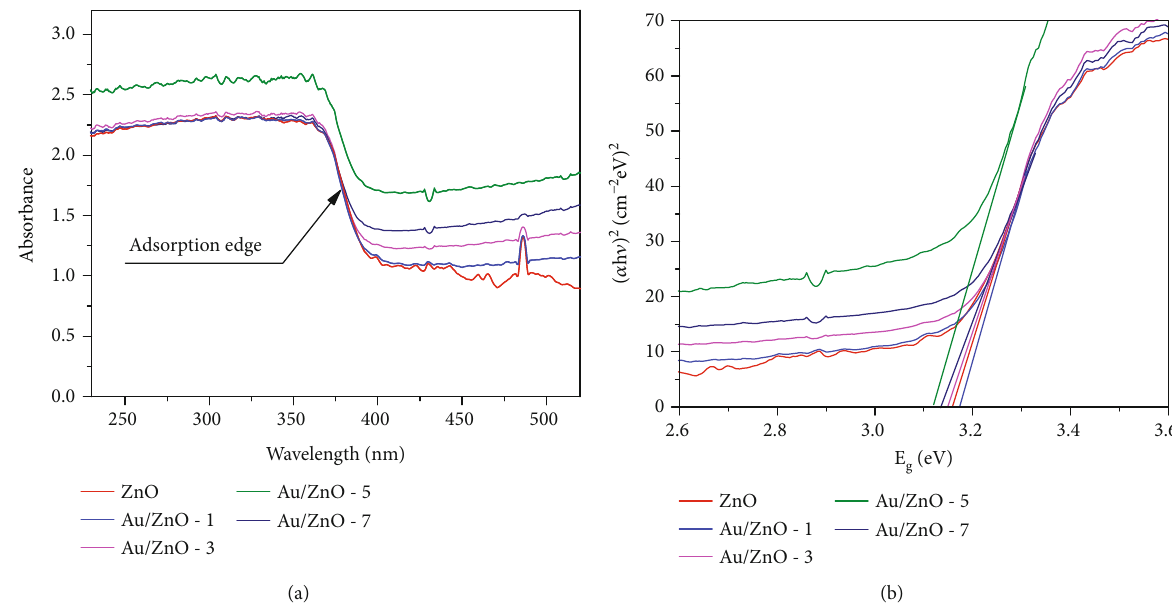
Figure 2: (a) DR/UV-vis and (b) Tauc ’ s plots of the